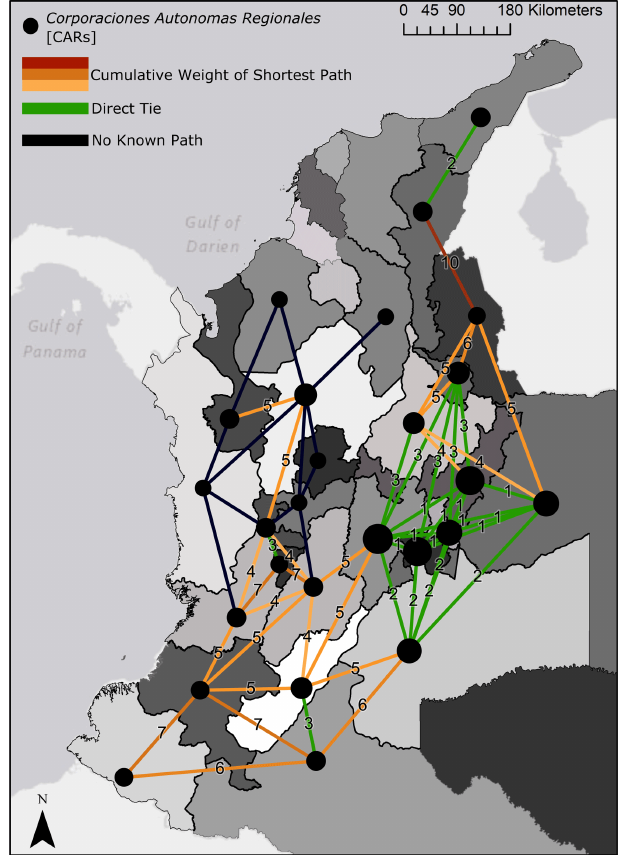
Fig. 7 . The inclusion of nongovernmental organizations and Colombia’s National Natural Park Service brought most (n = 21; 81%) of the autonomous regional corporations ( corporaciones autonomas regionales [CARs]) into a single connected component. Cumulative weights of the intervening paths between CARs that did not directly communicate with one another (but did share correspondents) are provided; a higher weight suggests that information is less likely to travel from one CAR to the other. CARs connected by lines of any color are considered ecologically connected via probable movement of Andean bears ( Tremarctos ornatus